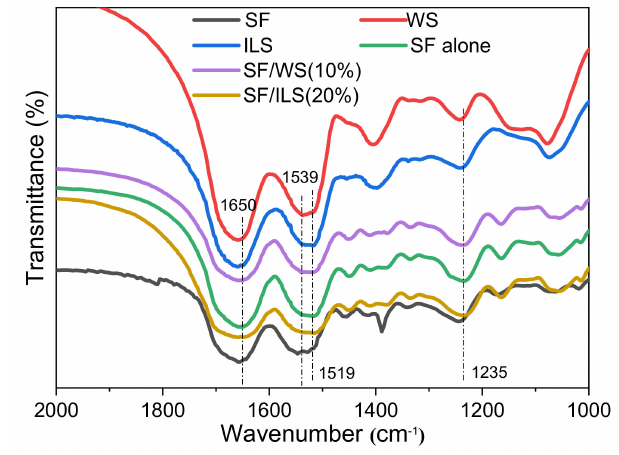
Figure 6. FT-IR spectra of various SP scaffolds.